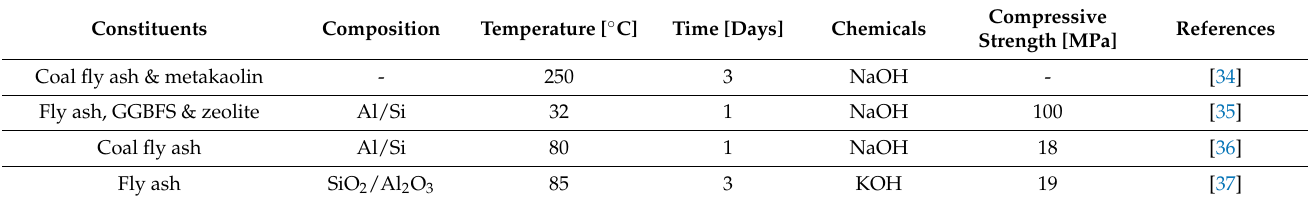
Figure 5. SEM micrographs of illustration of ( a ) geopolymers sample immersed in water exhibited glass-like microstructural surface and ( b ) geopolymers sample after acid exposure showed debris-like colloidal particles (could be the precipitates of silica gel) on the surface. Reprinted with permission from Ref. [30]. Copyright 2018, with permission from Elsevier. Table 1. A brief summary of the constituents of